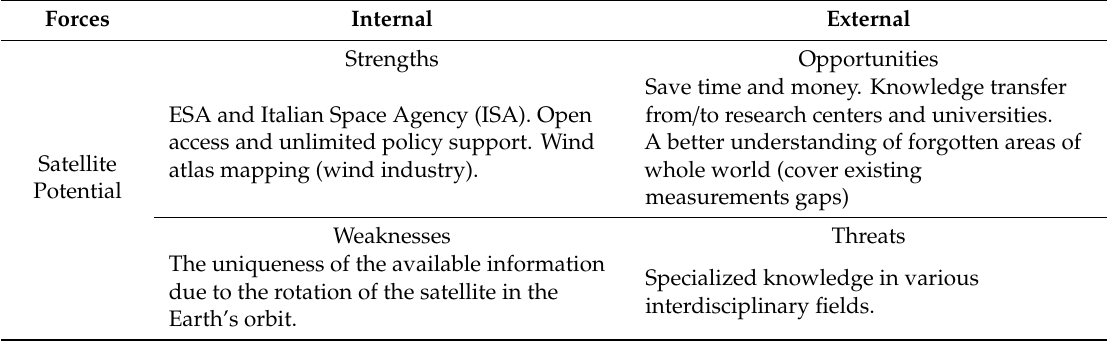
Table 1. SWOT (Strengths, Weaknesses, Opportunities and Threats) analysis of satellite potential.